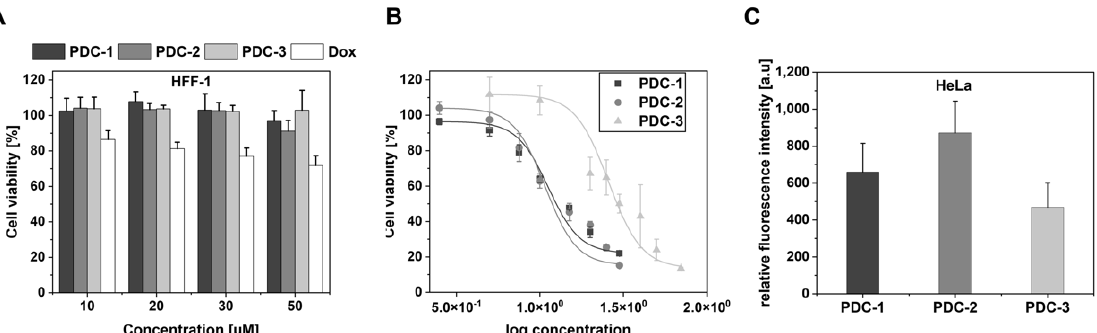
Figure 5. ( A ): Cytotoxicity assay using HFF-1 cells. Different PDC concentrations were incubated with the cells for 24 h at 37 °C and a resazurin assay was conducted. ( B ): Dose-response curves for peptide drug conjugates were obtained using the resazurin assay. For this, HeLa cells were treated with various conjugate concentrations (2.5 – 70 µM) for 24 h at 37 °C. ( C ): Quantification of PDC internalization in HeLa cells; 10 µM PDC solutions were incubated with cells for 30 min at 37 °C and cells were inspected using a flow cytometer; assays were conducted in triplicate n = 3.